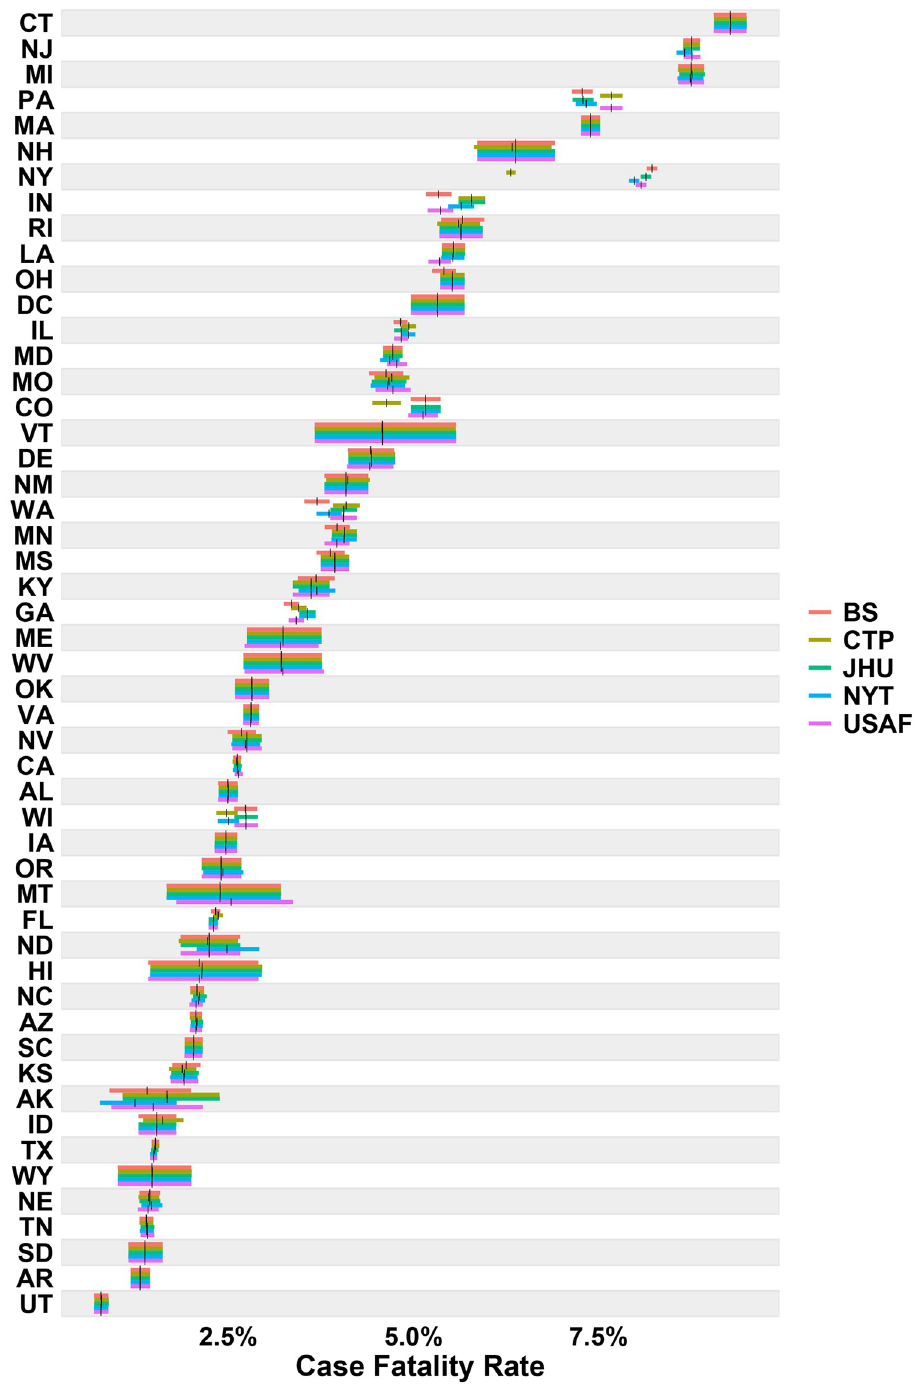
Fig 5. Aggregated (June 30, 2020) case fatality rate across states and sources. The horizontal bars represent the 90% equal-tail credible intervals, with the vertical black bars indicating the posterior means.